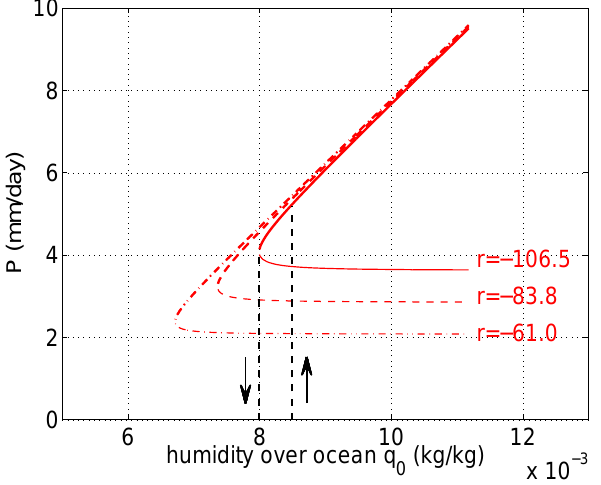
Fig. 11. Physical solution for EASM precipitation P from the con- ceptual model, for three different values of the non-dimensional pa- rameter r : r(t) (dashed), r(t) + σ/ 2 (dot-and-dash), and r(t) − σ/ 2 (solid), where r(t) is the estimate from NCEP/NCAR reanalysis data, and σ denotes a standard deviation. Bold lines indicate the upper, stable branch. The value r(t) − σ/ 2= − 106.5, which corre- sponds to a critical threshold q c o =8.0gkg − 1 , is used for the com- parison of the model with EASM proxy data. Vertical dashed lines mark q c o and q c o + 1 q , where we choose 1 q =0.5gkg − 1 as the width of an assumed hysteresis that is thought to appear when the threshold is crossed from either side (illustrated by arrows).